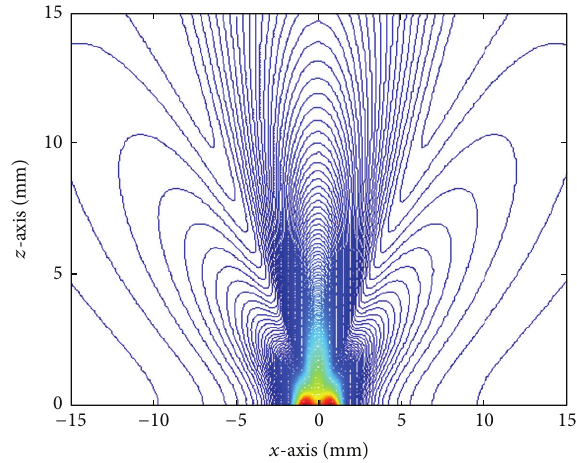
Figure 6: Acoustic pressure variation in 𝑥 - 𝑧 plane.